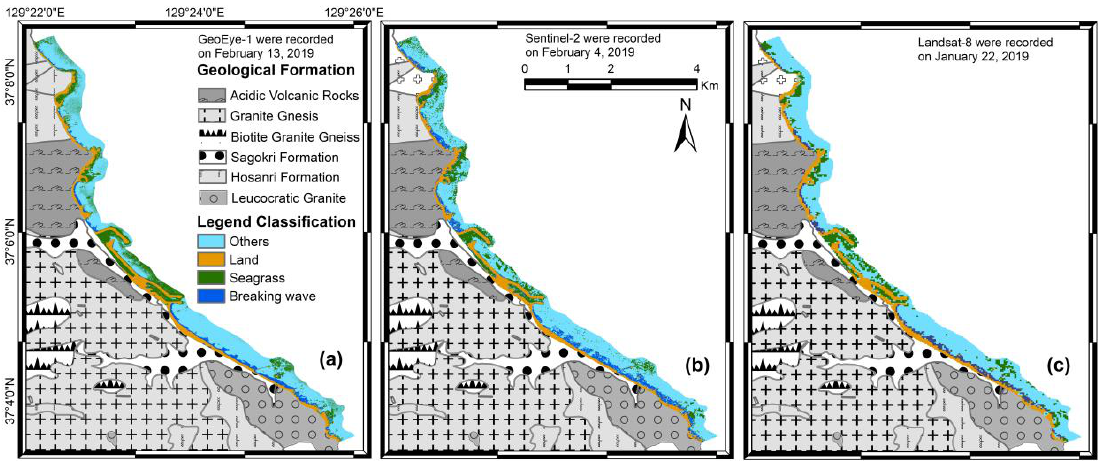
corrections of Sentinel-2, and ( i ) water column corrections of Landsat-8.